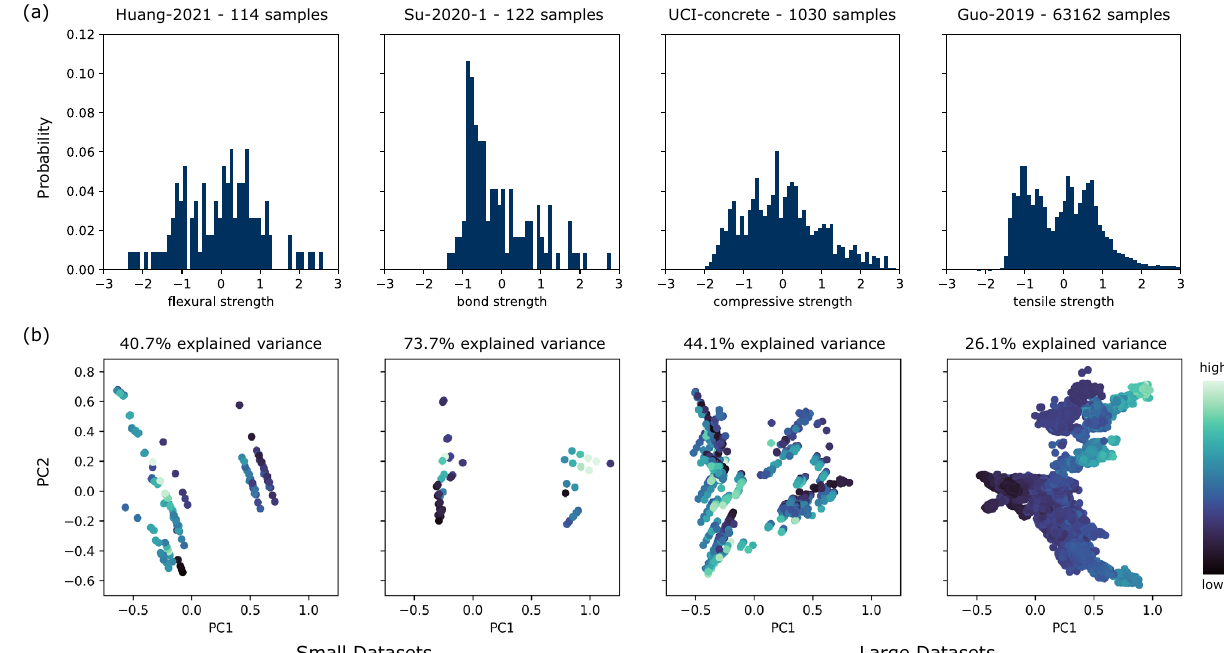
Figure 2. Design space visualisation from chosen datasets. ( a ) Histogram of one target value normalized via standard scaler. ( b ) Representation of the standardized input feature space for the selected datasets via visualization of the first two principal components , the color of the points represents the target value.